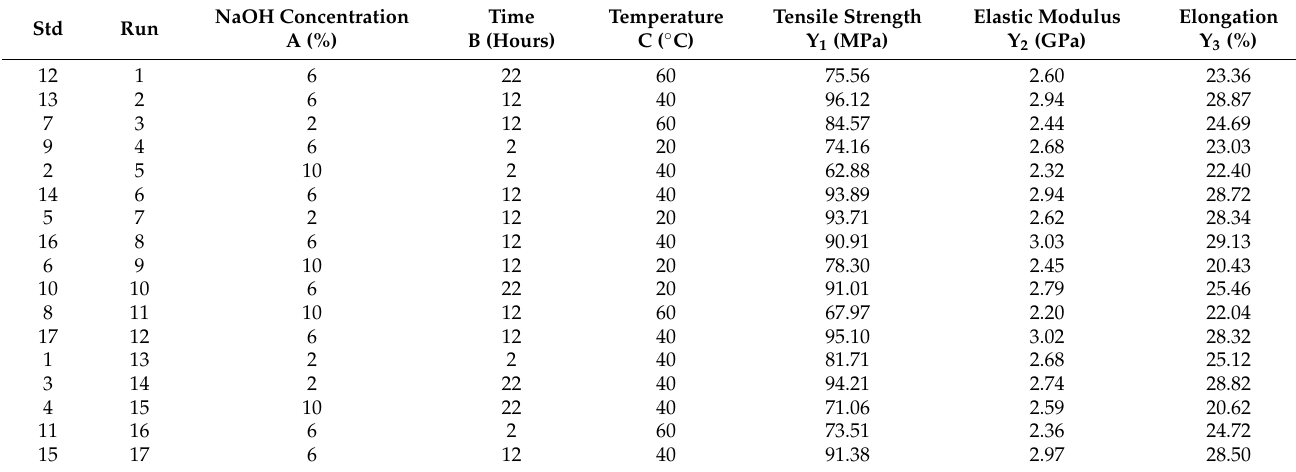
Table 2. Alkaline treatment conditions and test results of coir fibers.